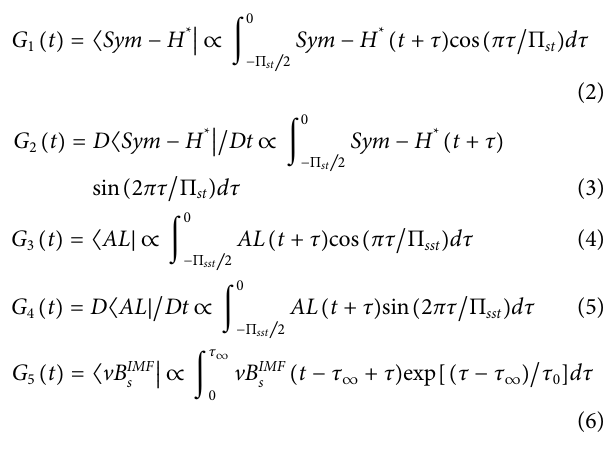
Frontiers in Physics |